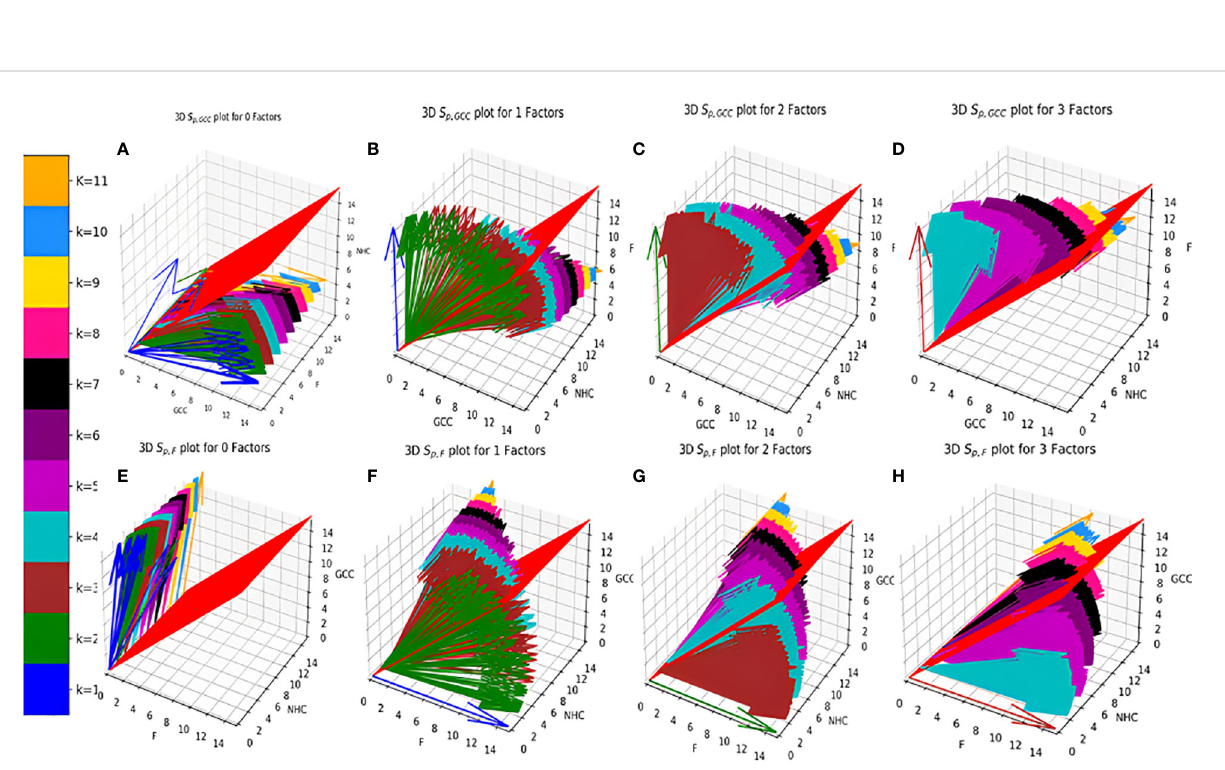
FIGURE 4 Distribution of S k , k F p , GCC Vs S k , k F p , F (A – D) . S k , k F p , GCC (E – H) . S k , k F p , F . (A) zero Factors; (B) 1 Factor; (C) 2 Factors; (D) 3 Factors; (E) zero Factors; (F) 1 Factor; (G) 2 Factors; (H) 3 Factors.